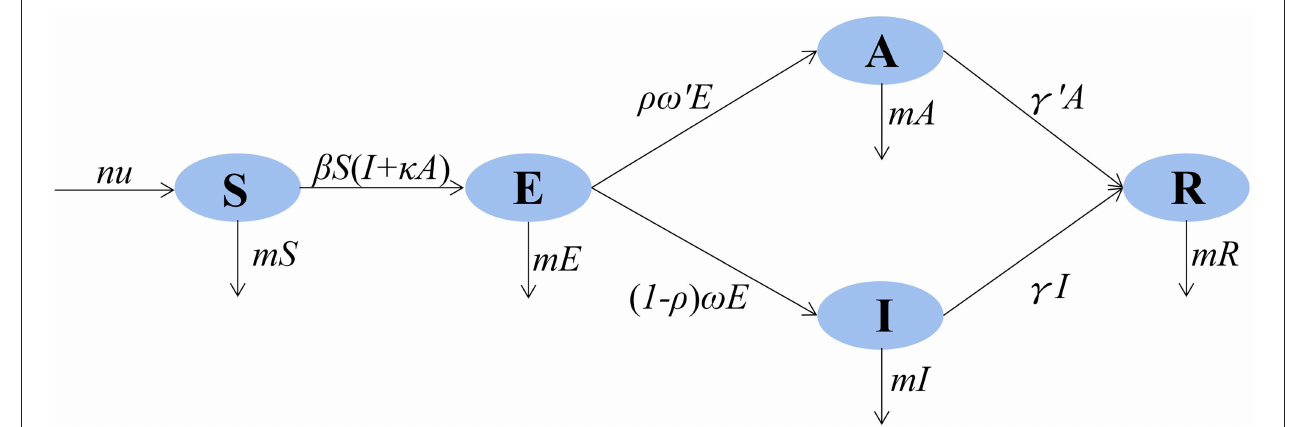
FIGURE 1 | SEIAR (susceptible–exposed–infectious–asymptomatic–recovered) model framework of mumps in Wuhan City.